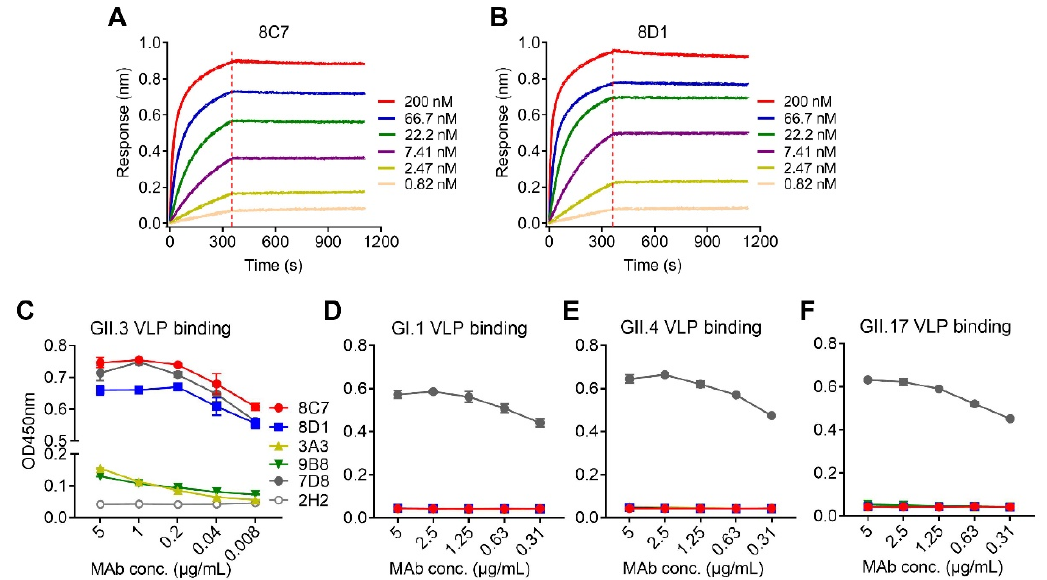
Figure 1. Binding affinity and specificity of the mAbs to GII.3 VLP. ( A , B ) Biolayer interferometry sensorgrams of anti- GII.3 mAbs 8C7 ( A ) and 8D1 ( B ) binding to biotinylated GII.3-KJ VLP on streptavidin-coated biosensors. Association and dissociation steps are divided by dashed lines. The mAb concentrations were shown. ( C – F ) Reactivity of anti-GII.3 mAbs (8C7, 8D1, 3A3, and 9B8) with GII.3-KJ VLP ( C ), GI.1 VLP ( D ), GII.4 VLP ( E ), and GII.17 VLP ( F ) were determined by ELISA. Data are mean ± SD of triplicate wells. 7D8, a norovirus cross-reactive antibody, used as a positive control. 2H2, an anti-SARS-CoV-2 mAb, used as a negative control. Conc., the abbreviation for concentration. Table 2. Characteristics of the anti-GII.3 mAbs.